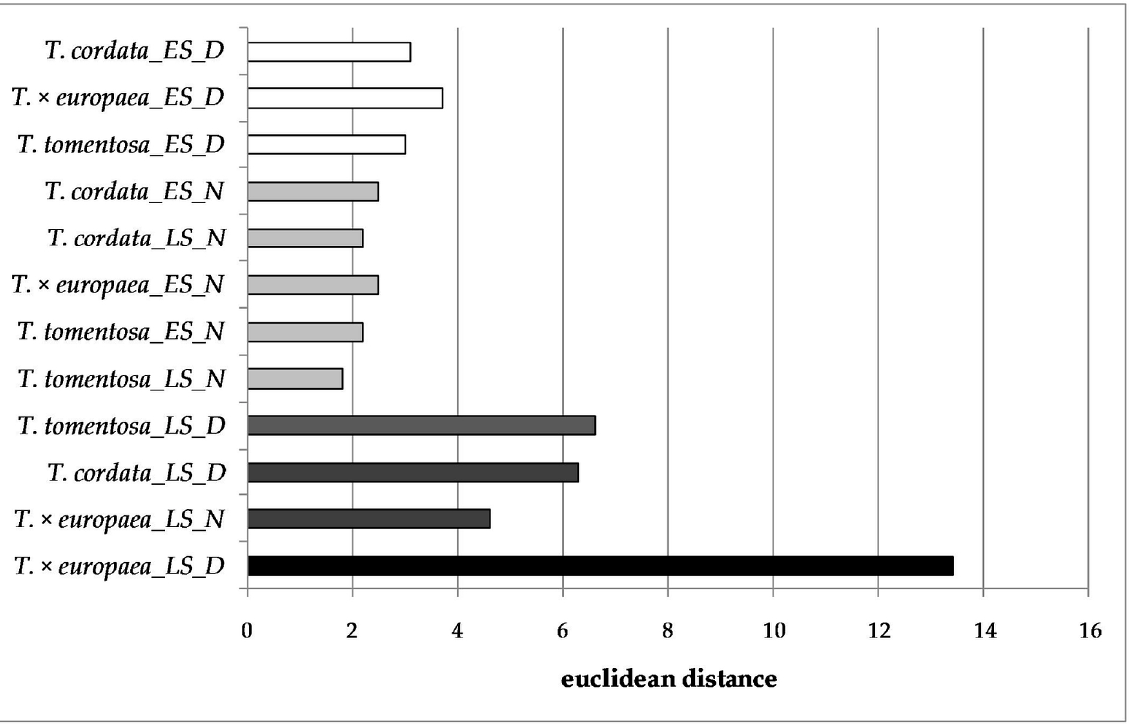
Figure 6. Euclidean distance between full development and other developmental phases in each species and category (D or N), separately. White bars indicate objects classified into cluster 1, light grey bars—cluster 2, dark grey bars—cluster 3 and the black bar—cluster 4.